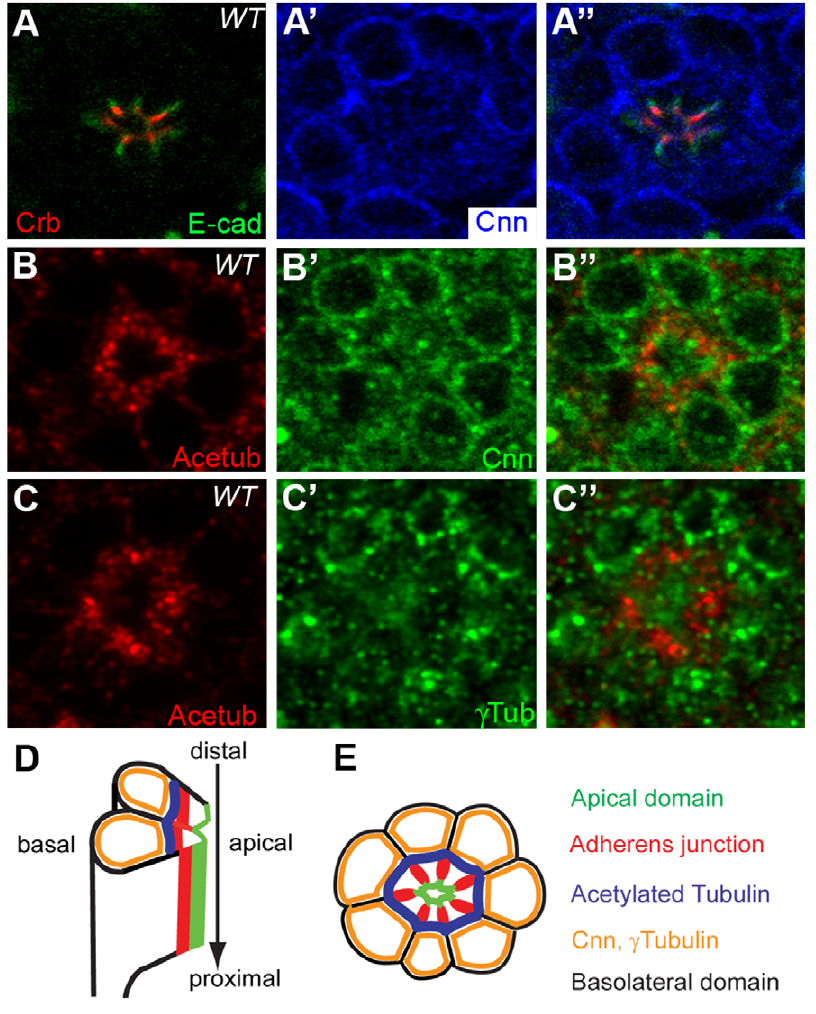
Figure 3. Localization of Cnn in Drosophila pupal photoreceptors. Localization of Cnn in mid-stage (50% pd) of pupal eyes were examined. (A) Pupal eyes were stained with Crb (apical marker, red, A), E-cad (green, AJ, A) and Cnn (blue, A 9 ). The Cnn (blue, A 9 ) localized more basal to the apical domain of Crb and AJ of E-cad. (B) The Cnn (green, B 9 ) localized more basal and adjacent to the acetylated microtubules (Acetub, red, B). (C) Acetylated microtubules (red, C) localized more apical and adjacent to the c -Tubulin ( c -Tub, green, C 9 ).